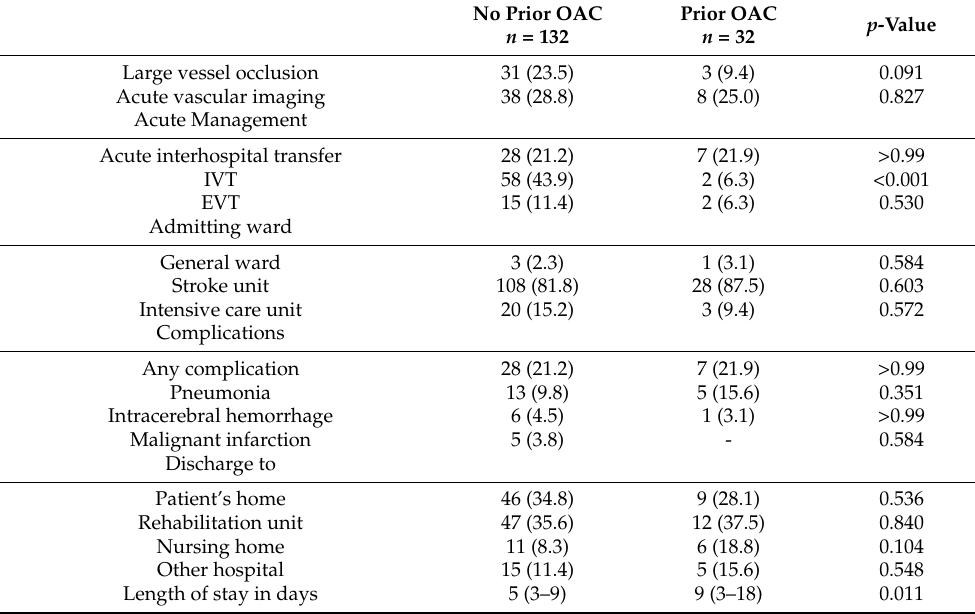
Table A2. Management of patients with ischemic stroke presenting within 4.5 h after onset of symptoms categorized according to anticoagulation status at admission ( n =